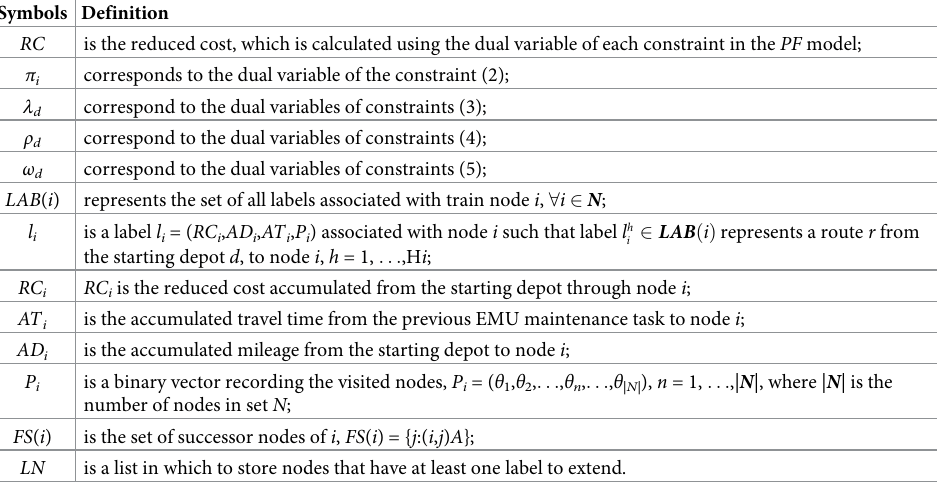
Table 4. Definitions of the symbols used in the algorithm. Symbols